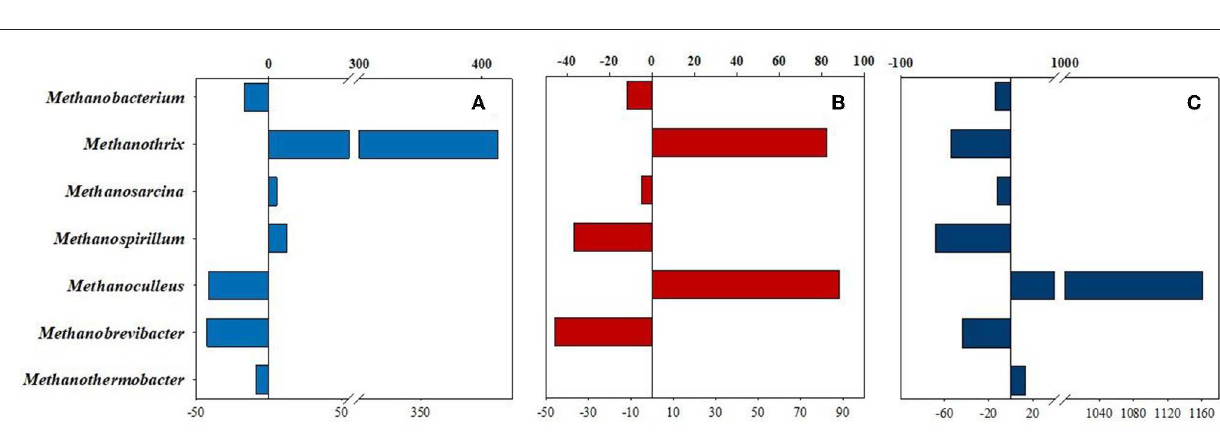
FIGURE 6 | Relative abundances of the Archaea genera. The compositions of the reactors were as in Figure 3 .